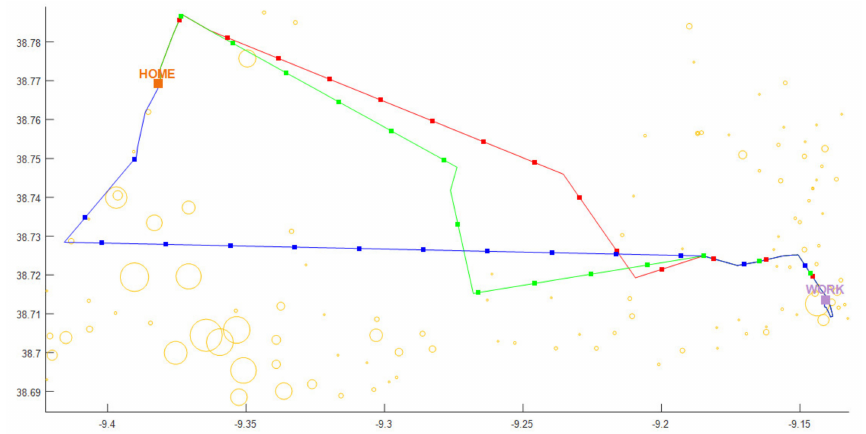
Figure 5. An example of route choices (shown in Figure 3) after interpolation that equalizes the number of waypoints of all possible route choices.